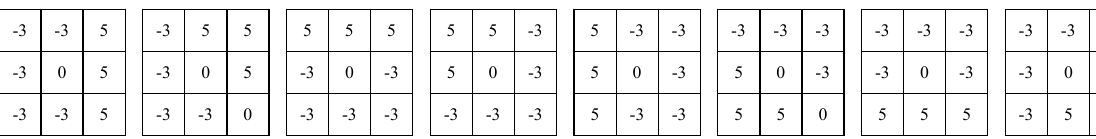
Figure 3. The masks of Kirsch